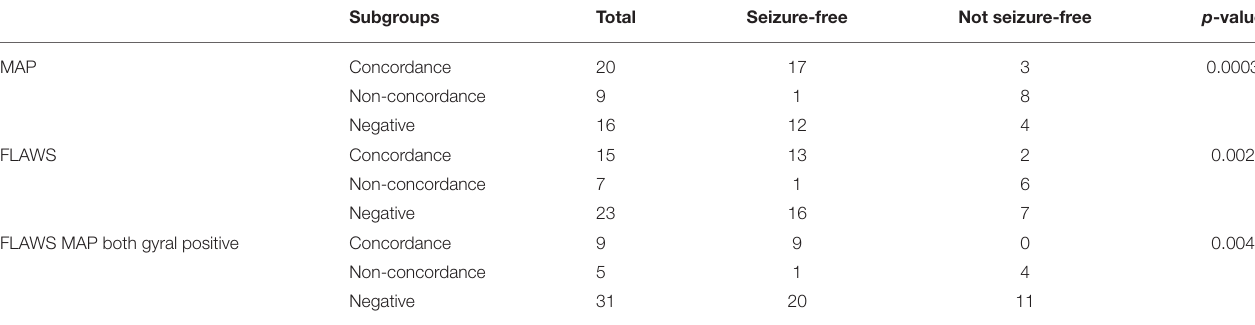
TABLE 3 | Correlation between resection of positive regions and seizure outcomes.